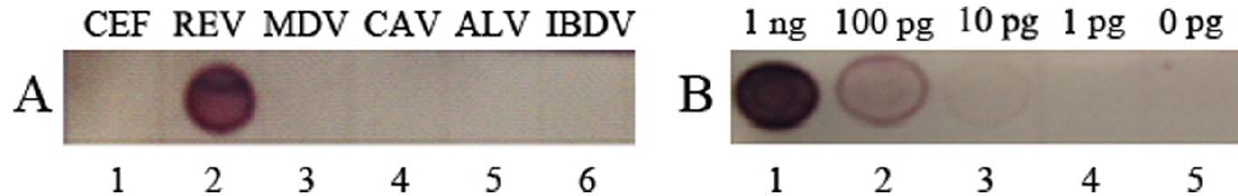
Figure 1. Examination of the specificity and sensitivity of REV env gene probe. (A) The specificity of REV env gene probe. Dot 1, DNA from CEF; dot 2, DNA from CEF inoculated with strain SNV of REV; dot 3, DNA from CEF inoculated with MDV; dot 4, DNA from CEF inoculated with CAV; dot 5, DNA from CEF inoculated with ALV; dot 6, DNA from CEF inoculated with IBDV. (B) The sensitivity of REV env gene probe. Dot 1 to 4, DNA from diluted PCR product of REV env gene, 1 ng, 100 pg, 10 pg, 1 pg, respectively; dot 5, no DNA.